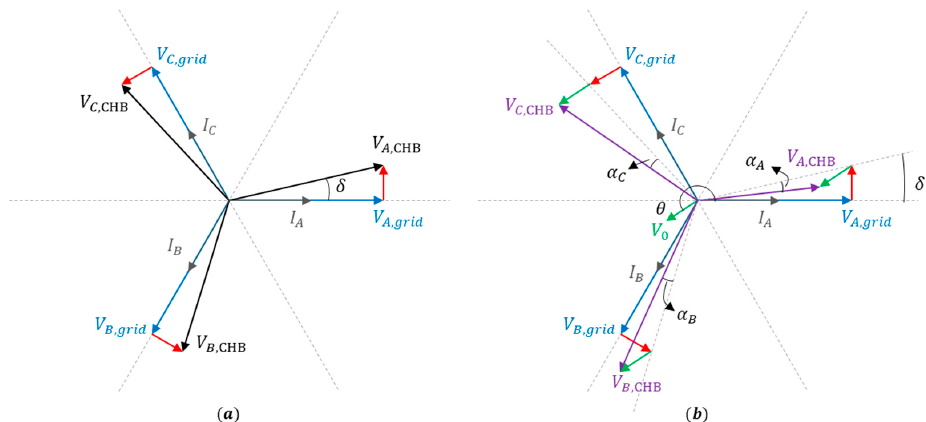
Figure 7. ( a ) Phasor diagram for normal operation; ( b ) Phasor diagram for unequal power generation ( Pa < Pc < Pb ).